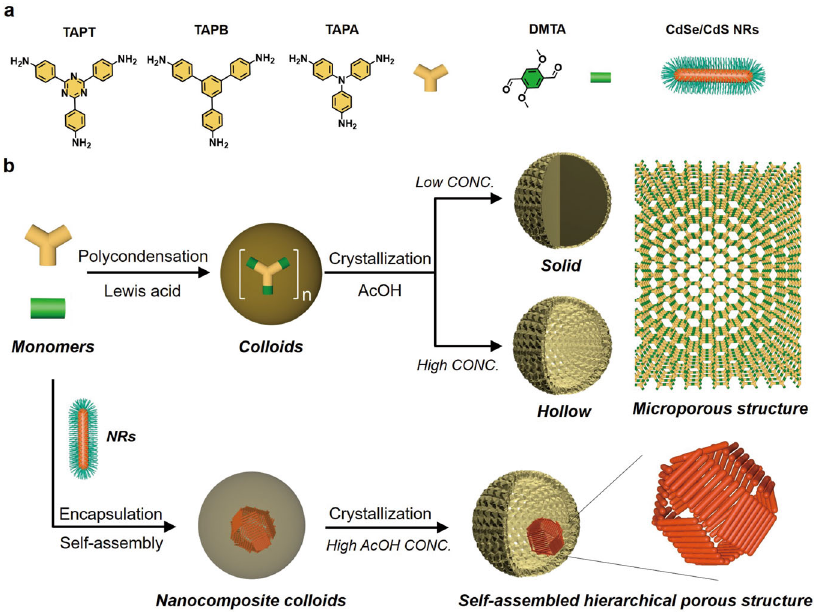
Fig.1|Schematicdiagramoftheformationofsuperstructures.a Schematicdiagramofthebuildingblocksusedforthesynthesisofporouspolymers. b Designconcept for building hierarchically porous nanocomposites from inorganic NRs and porous